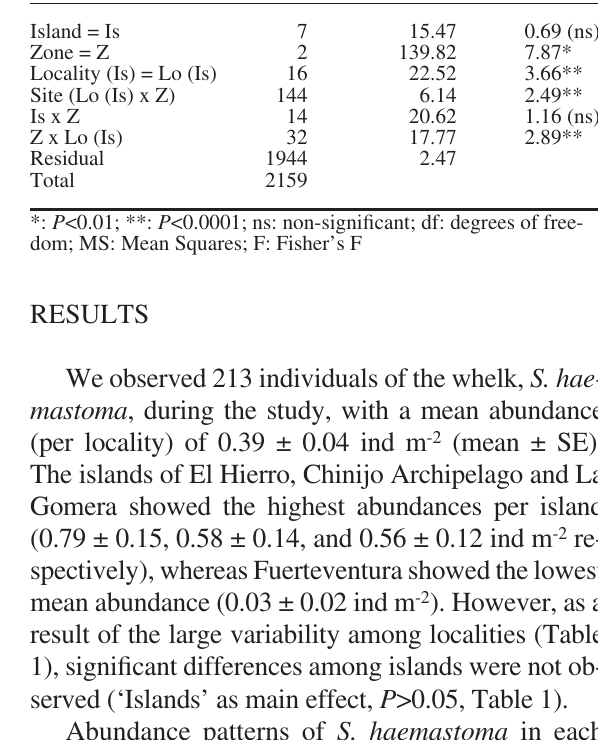
Table 1. − Results of the anoVa testing for differences between islands (fixed), intertidal zones (fixed and orthogonal), localities (random and nested within islands) and sites (random and nested within islands, zones and localities) in the mean abundances of Stra- monita haemastoma across the canarian archipelago. Source of variation